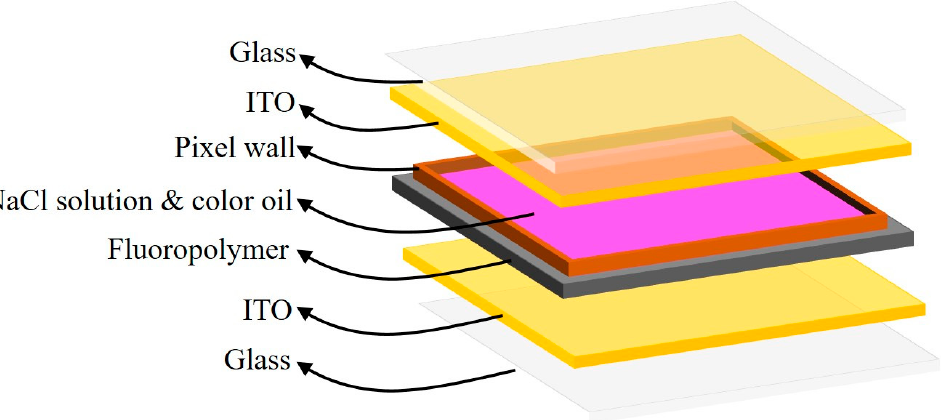
Figure 1. The structure of an EWD pixel. It is composed of a top glass, ITO electrodes, pixel walls, NaCl solution, color oil, a hydrophobic insulating layer (fluoropolymer), and a bottom glass. The color oil forms a thin film between the NaCl solution and the hydrophobic insulating layer, the pixel is in an “off” state.